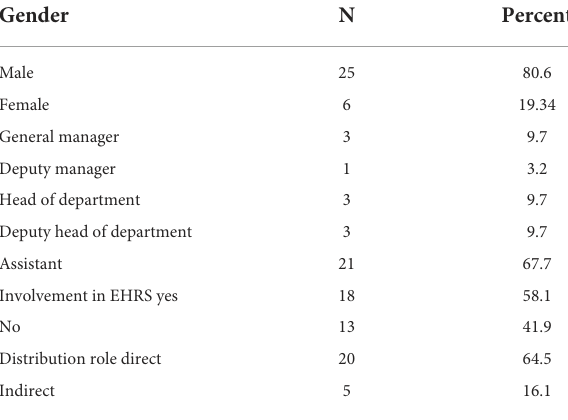
TABLE 1 Demographic information of